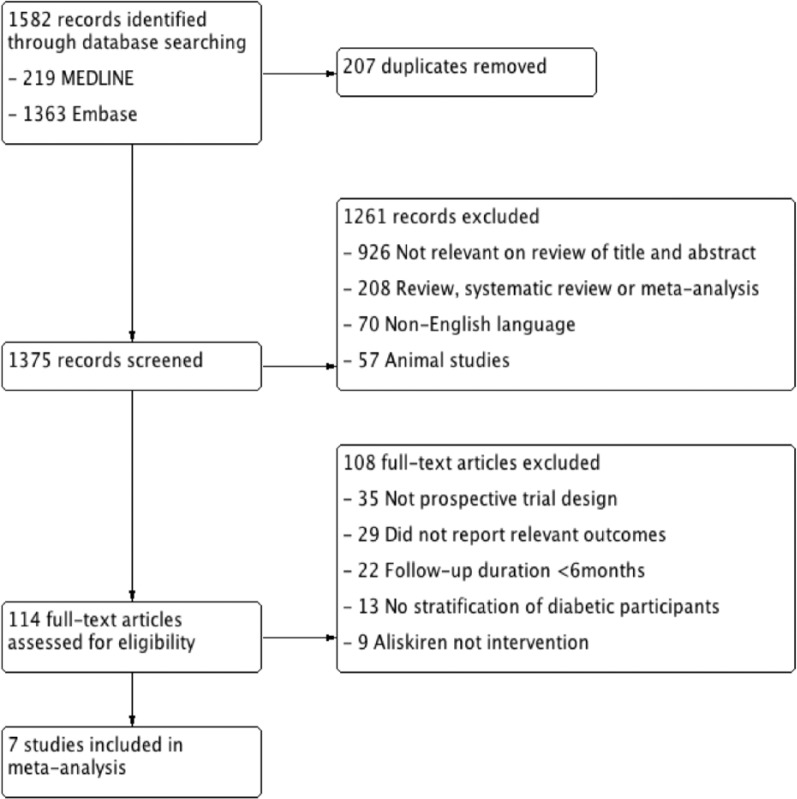
Study flow chart.